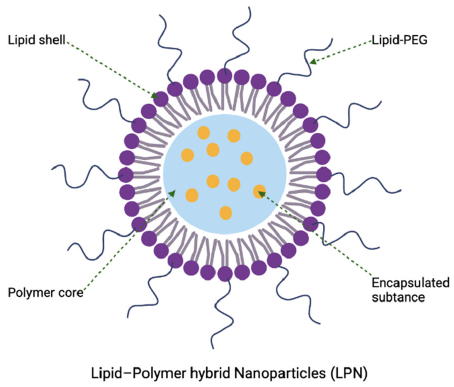
Figure 11. Structure of a lipid–polymer hybrid nanoparticle that comprises a polymeric core, an inner lipid layer, and an outer lipid–polyethylene glycol (PEG) shell (polymeric stealth layer). 4.5.1. Development of Lipid Polymer Hybrid Nanoparticles Using a